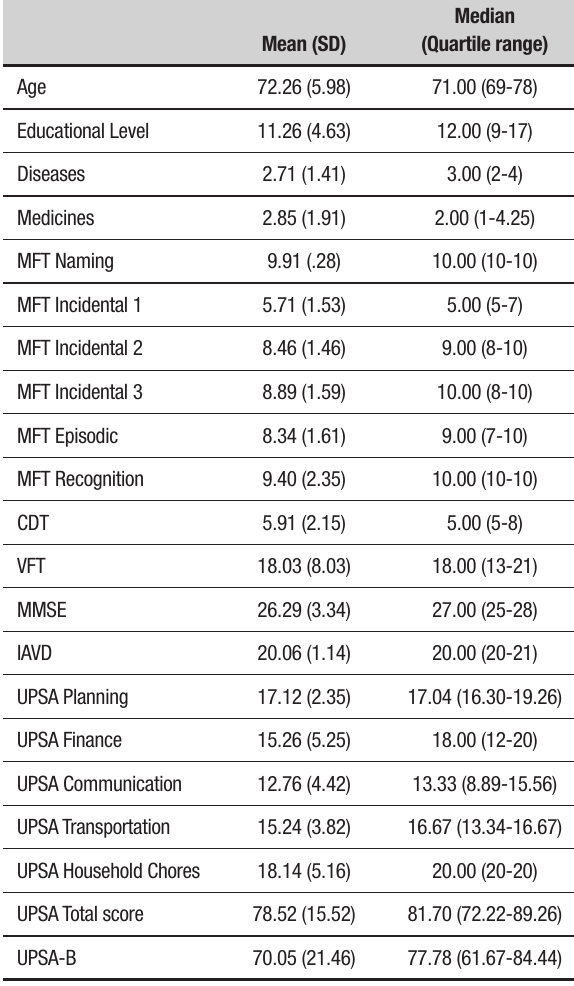
MFT: Memory of Figure Test; CDT: Clock Drawing Test; VFT: Verbal Fluency Test; MMSE-30: Mini Mental State Examination; UPSA: UCSD Performance-based Skill Assessment; UPSA-B: UCSD Performance-based Skill Assessment Brief